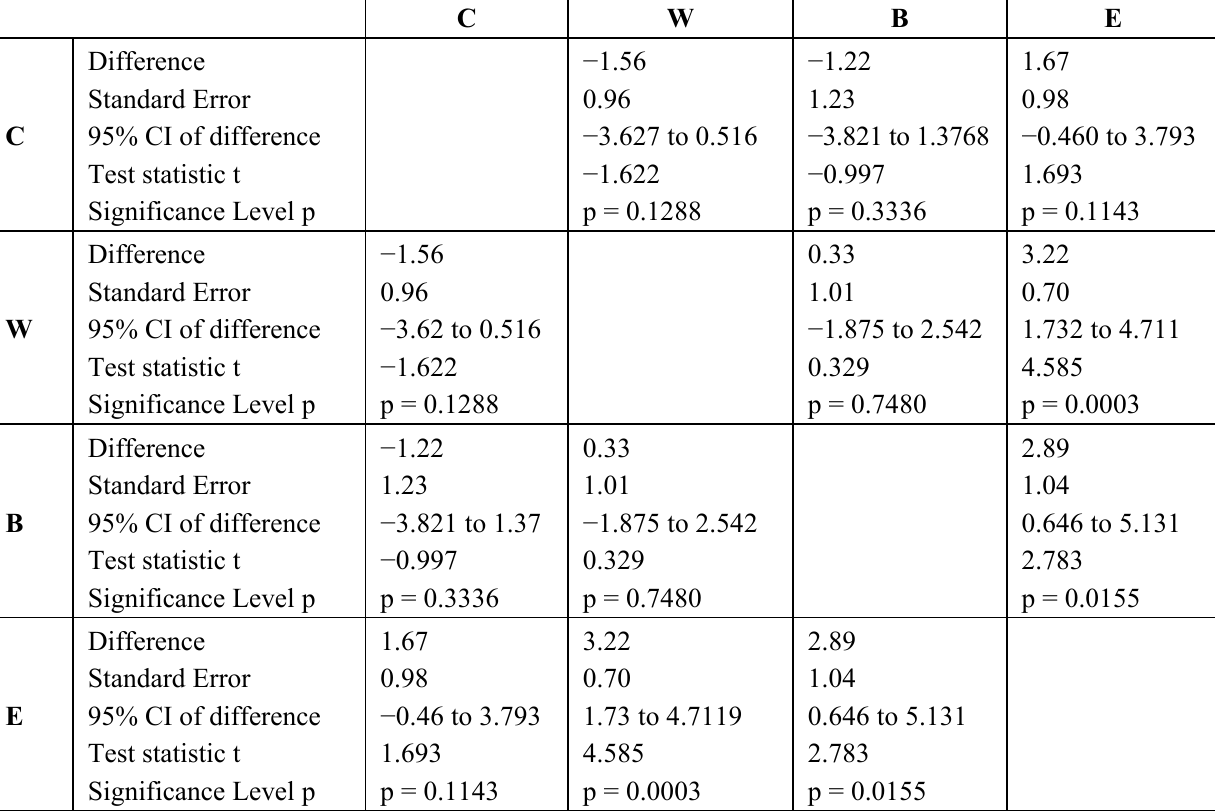
Table 6. Statistical differences between mean values of threshold after-discharge current strength *.